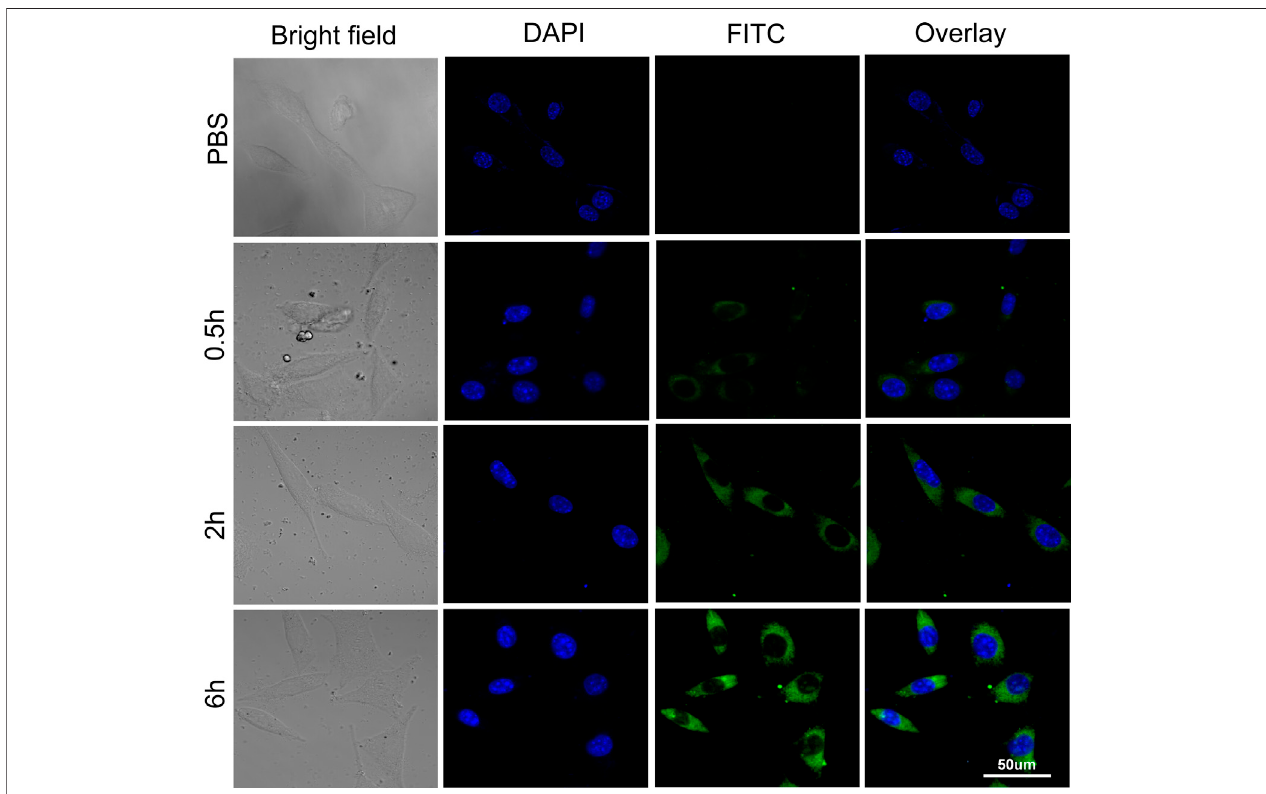
FIGURE 3 | Cell uptake of FITC-labeled Au-DENPs in HEIOC1 cells at 0.5, 2, and 6 h.